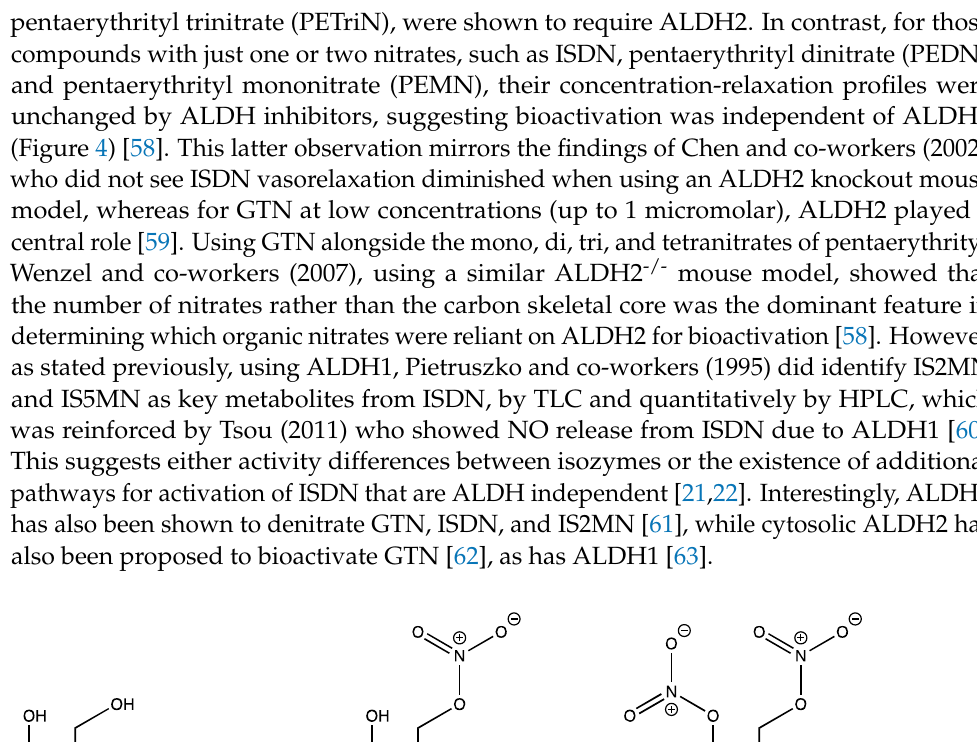
7 of 16 Figure 3. Chemical structures of ISDN, IS2MN and IS5MN. 12. The Use of ALDH Inhibitors and ALDH Knockout Models While the inhibitory effects of ISMN, ISDN, and GTN on ALDH are fascinating, a discrepancy of sorts was uncovered once vasorelaxation was studied in mouse and rat models. Using aldehyde dehydrogenase inhibitors, such as daidzin and benomyl [57], bi-